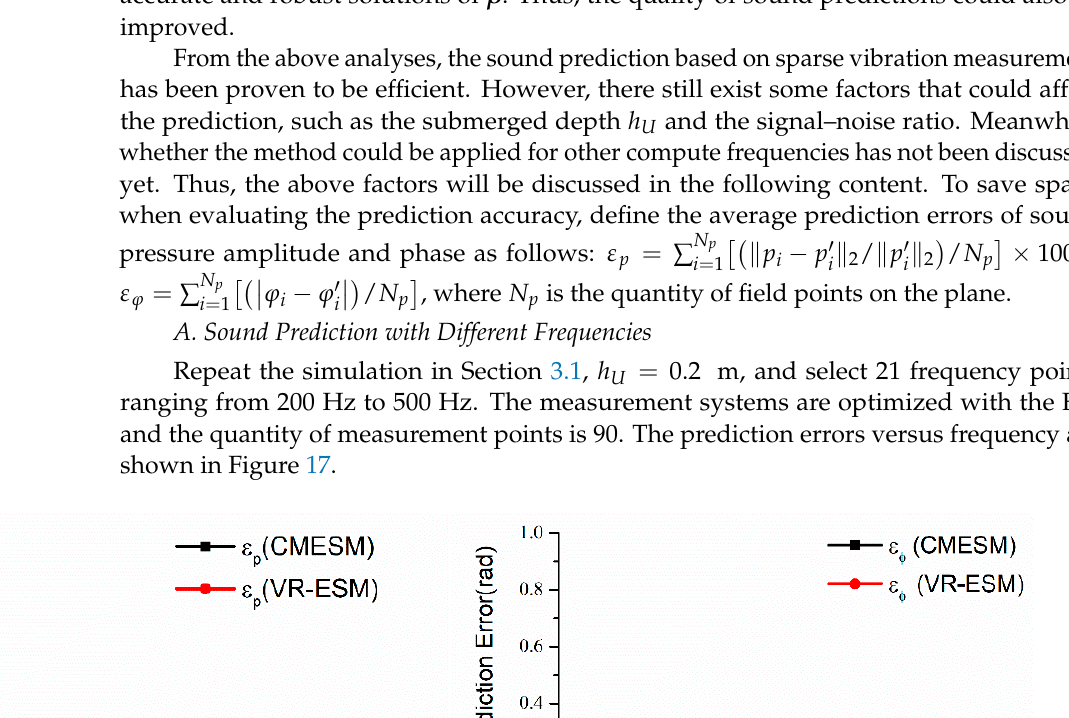
= 0.2 m). ( a ) ε p and ( b ) ε Φ U